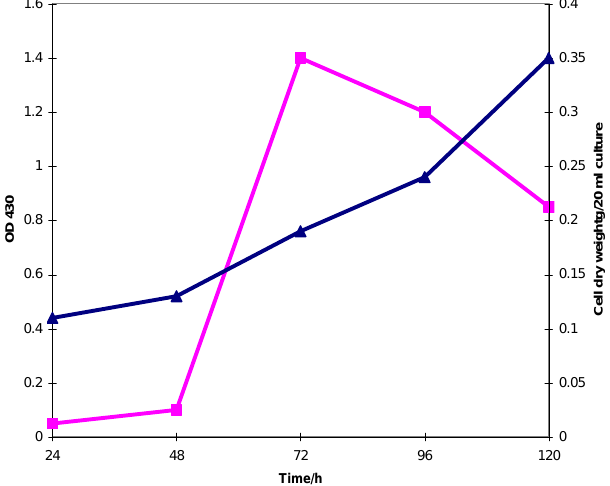
Figure 2 . Time course analysis of M. neoaurum exochelin production and cell dry